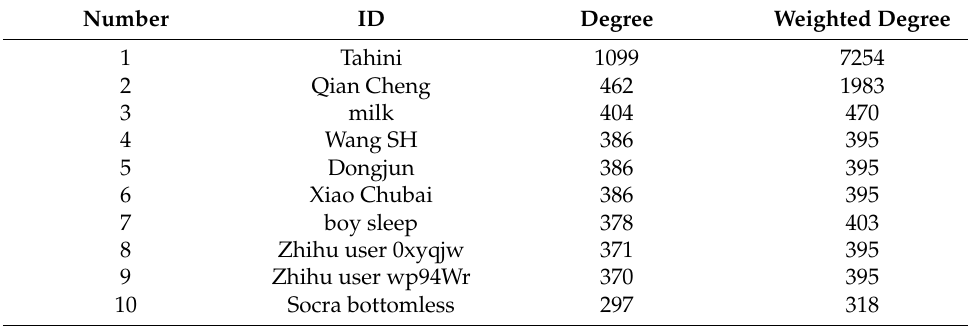
Table 1. The statistics of degree centrality for the top 10 users.